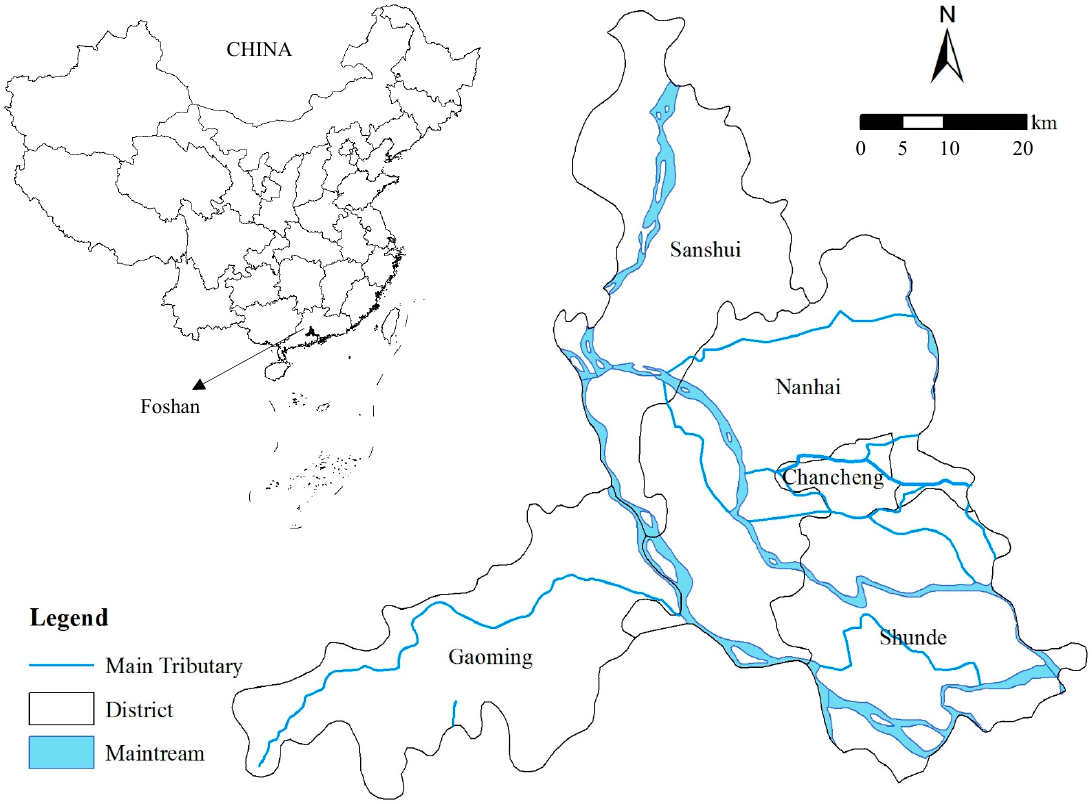
Figure 2. Location and river system of Foshan Municipality.